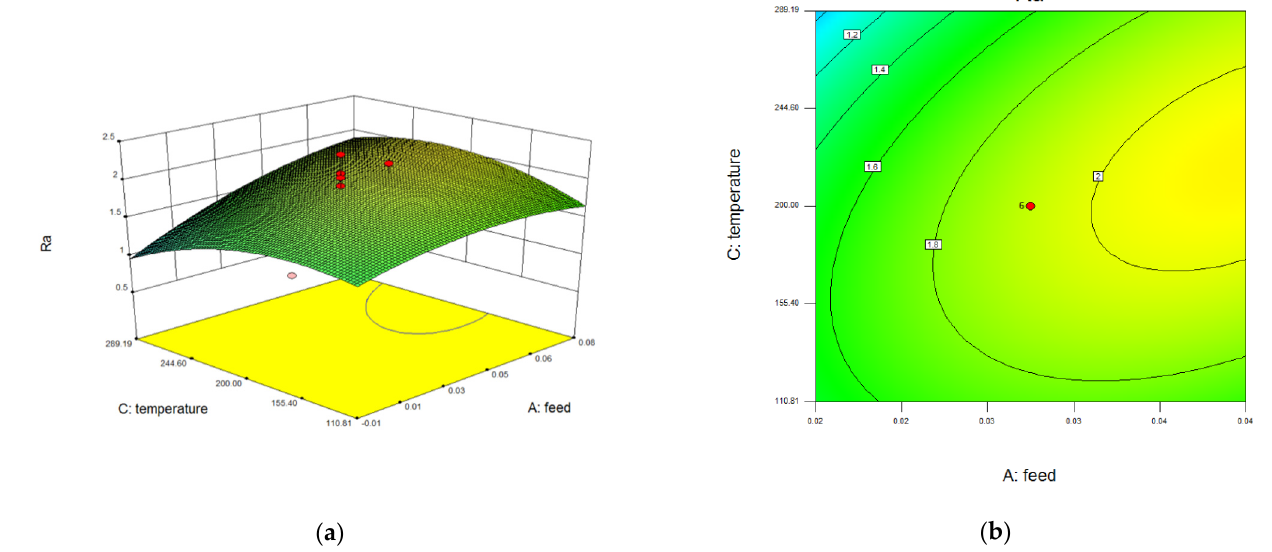
Figure 6. 3D surface plot and contour plot of R a for A and C: ( a ) 3D surface plot; ( b ) contour plot.